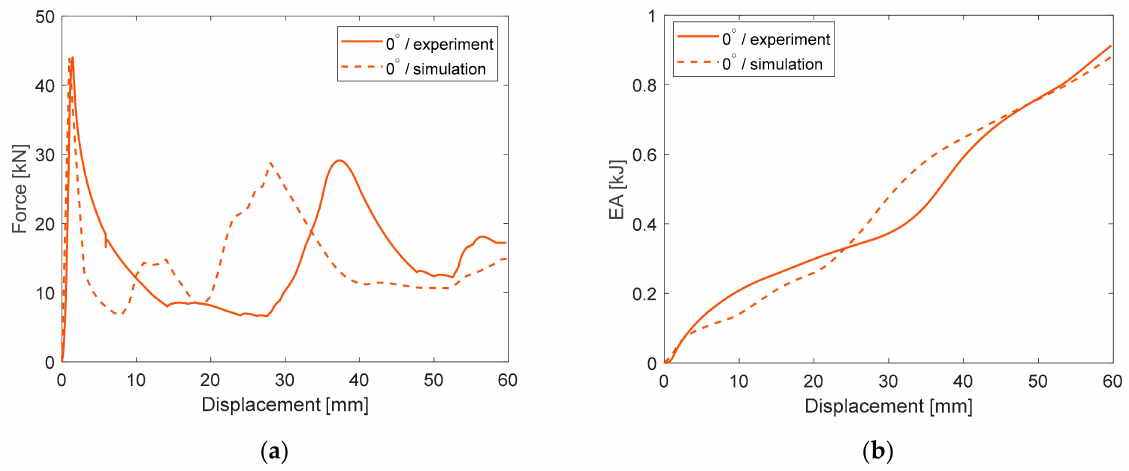
Figure 5. Experimental and numerical results of 0 ◦ crushing angle for axial impact. ( a ) force- displacement curve; ( b ) EA-displacement curve.